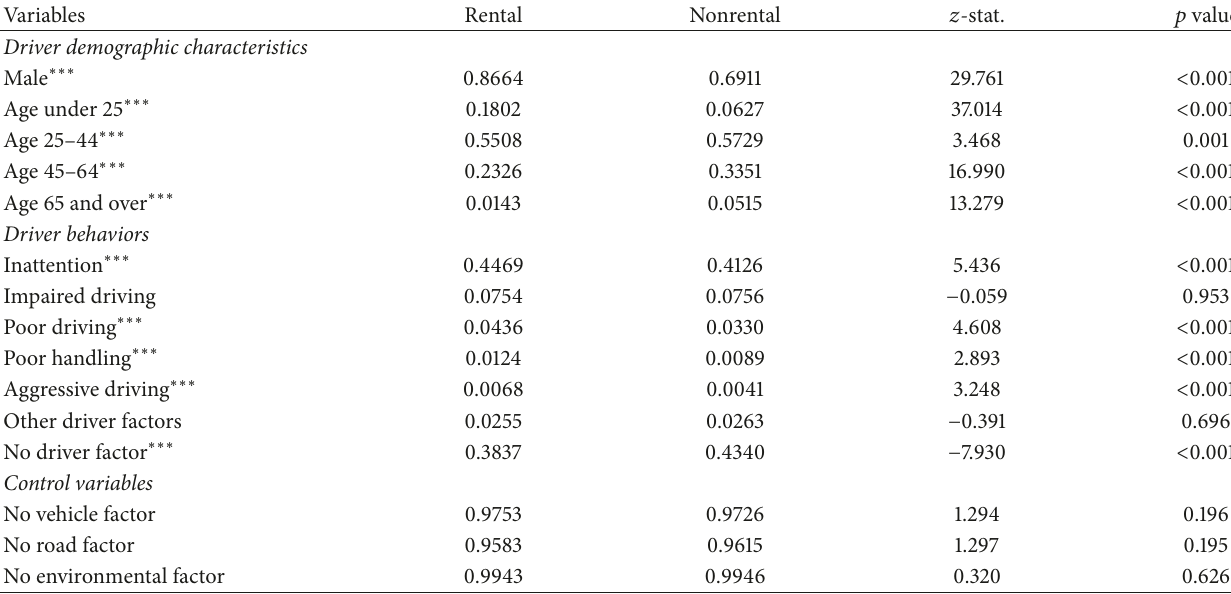
Table 2: Summary of variables by vehicle